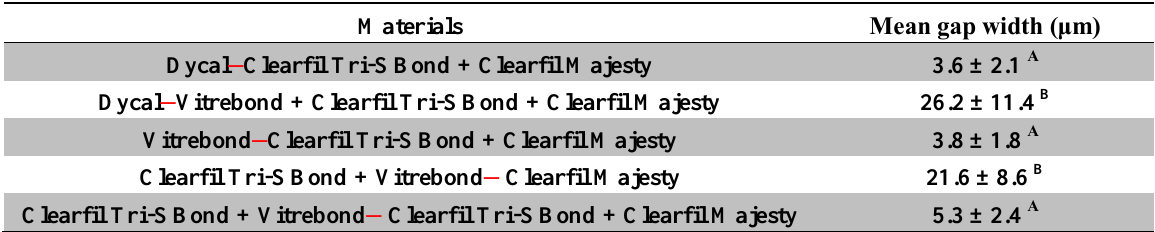
Table 4. The mean gap widths and standard deviations (μm) obtained between the materials tested. * Same letter between experimental groups indicate no significant difference (p>0.05)